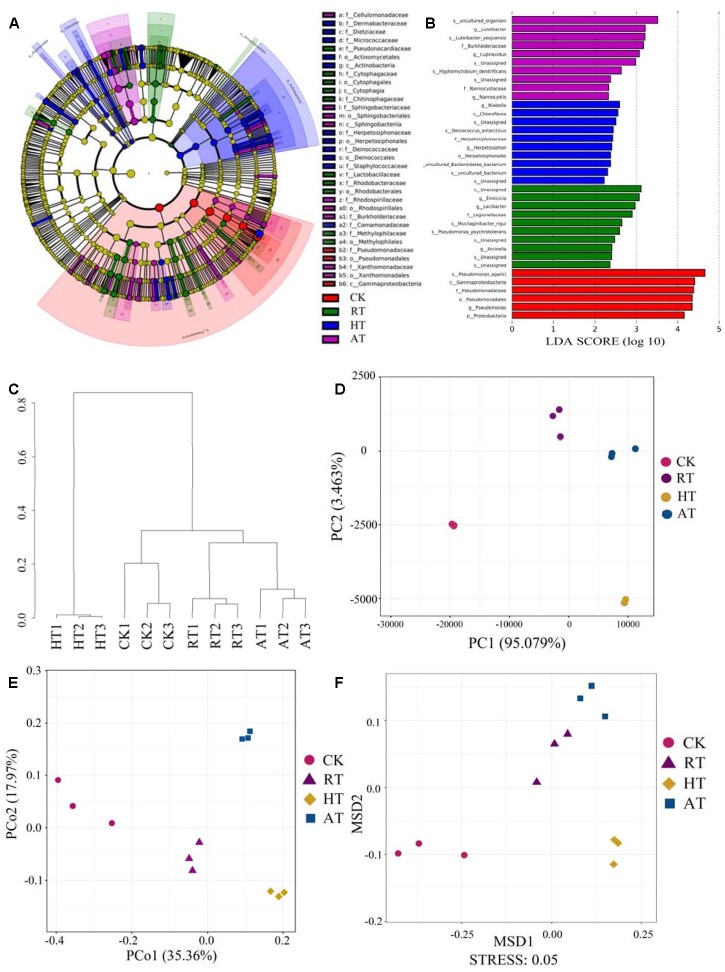
Beta diversity analysis of the exogenous bacteria in freeze-dried Agaricus bisporus under different storage conditions. (A) Cladogram generated from LEfSe analysis. (B) LDA scores of the differentially abundant taxa shown in (A). Taxa enriched are indicated with LDA score (taxa with LDA score >2 and significance of a <0.05 determined by Wilcoxon signed-rank test). (C) Cluster analysis. (D) PCA. (E) PCoA. (F) NMDS.